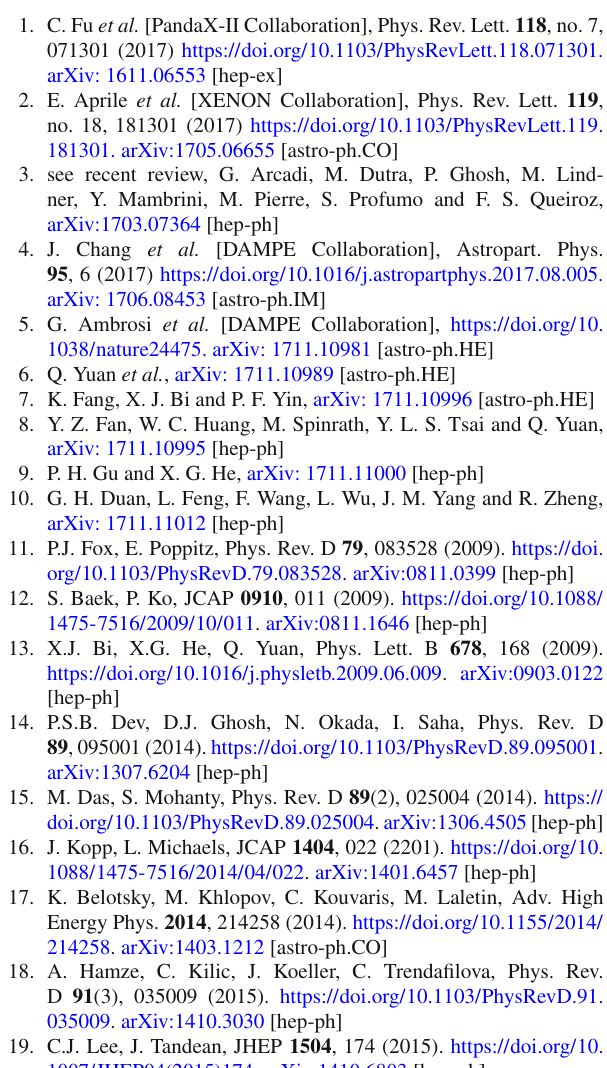
satisfy the DM relic density, the LEP bound, the DAMPE e + + e − flux excess and the PandaX